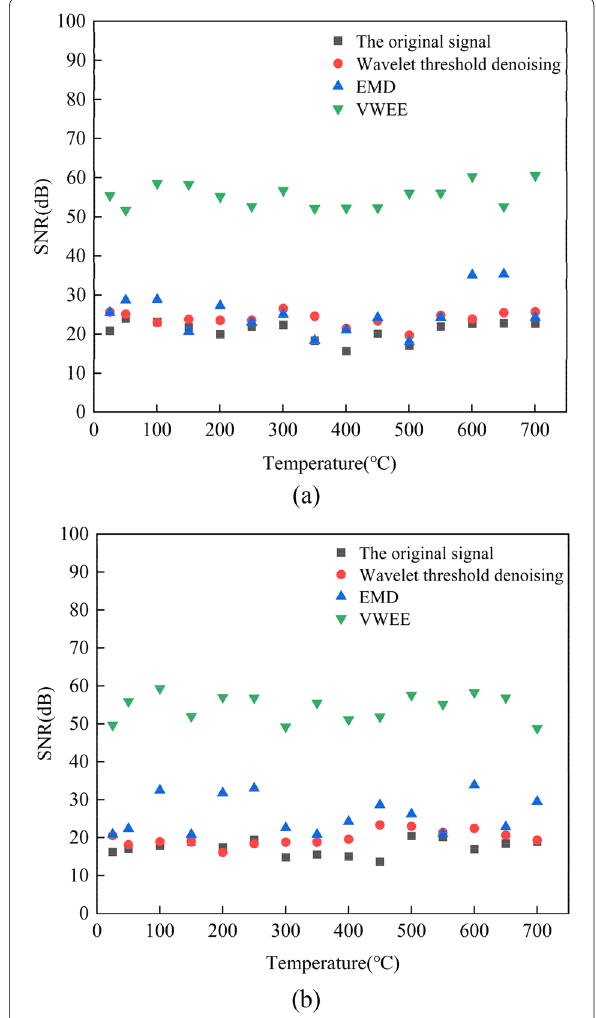
Figure 12 SNR at different temperatures of ( a ) Cr25Mo3Ti and ( b )